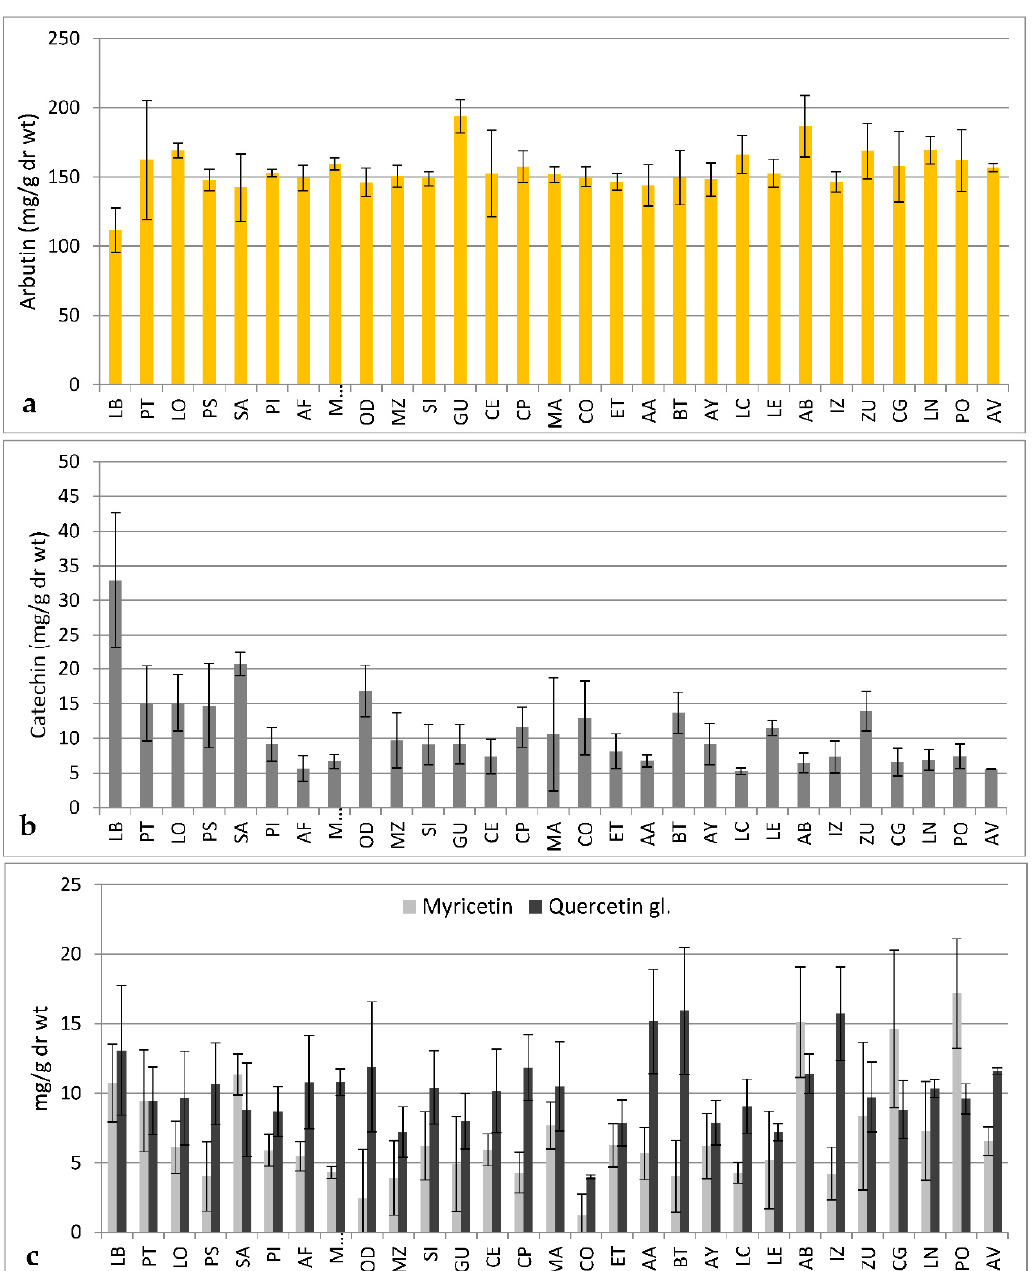
Figure 4. Mean contents (mg / g dr wt) of arbutin ( a ) and of the flavonoids ( + ) catechin ( b ), myricetin and quercetin glucoside ( c ) determined in leaves from 140 bearberry plants growing in 29 natural populations from Spain located in altitudes ranging from 534 (AV) to 1750 m a. s. l. (LB). Data are mean and standard deviation of 1–6 individuals sampled in 2016 and analyzed in